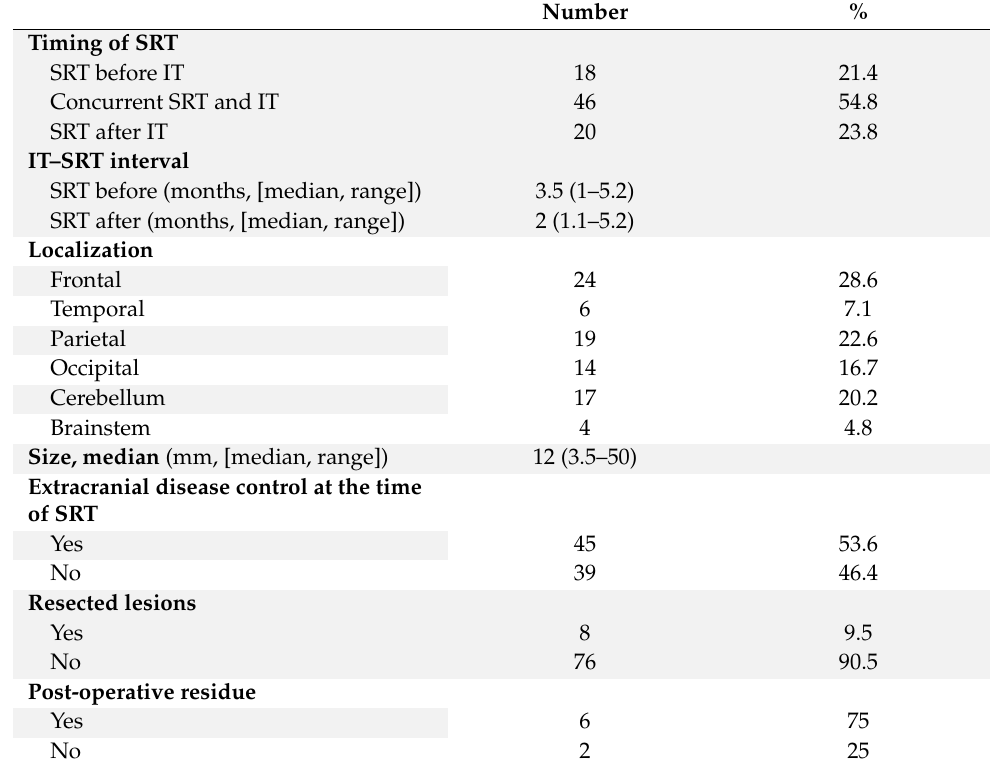
Table 2. Brain metastases and radiation therapy characteristics ( n =